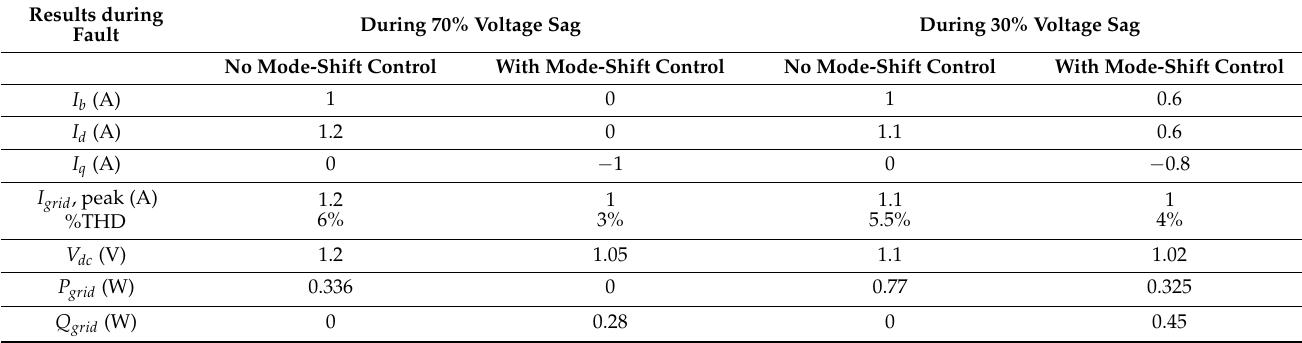
Table 3. Simulation performance